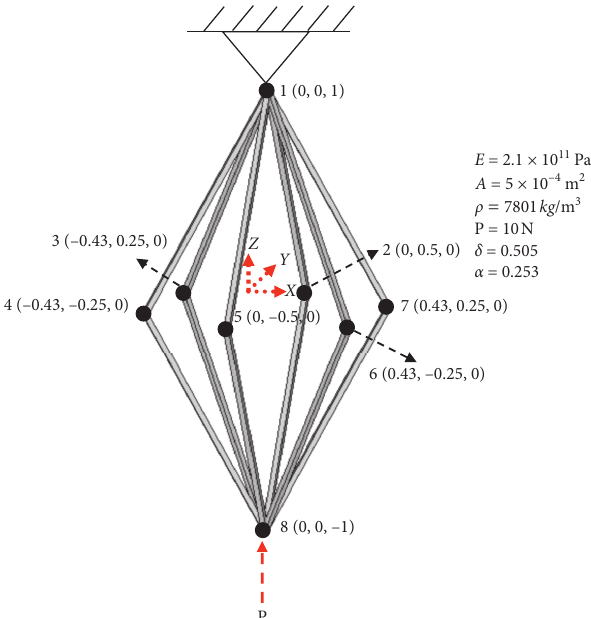
Figure 2: Initial mode shape of the deployable